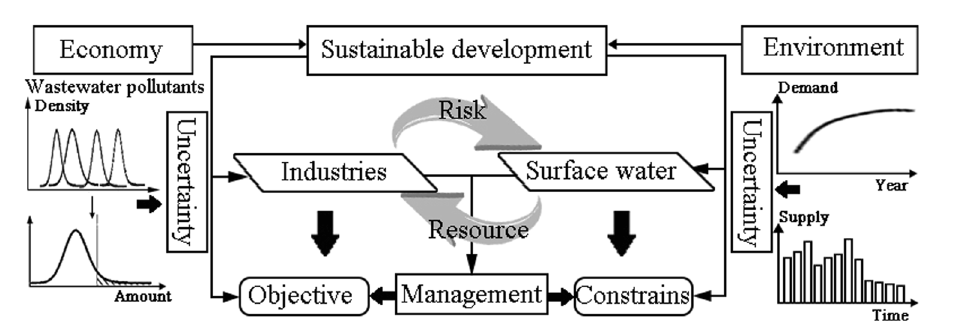
Figure 5. Industrial water and wastewater management under uncertain environmental-economic